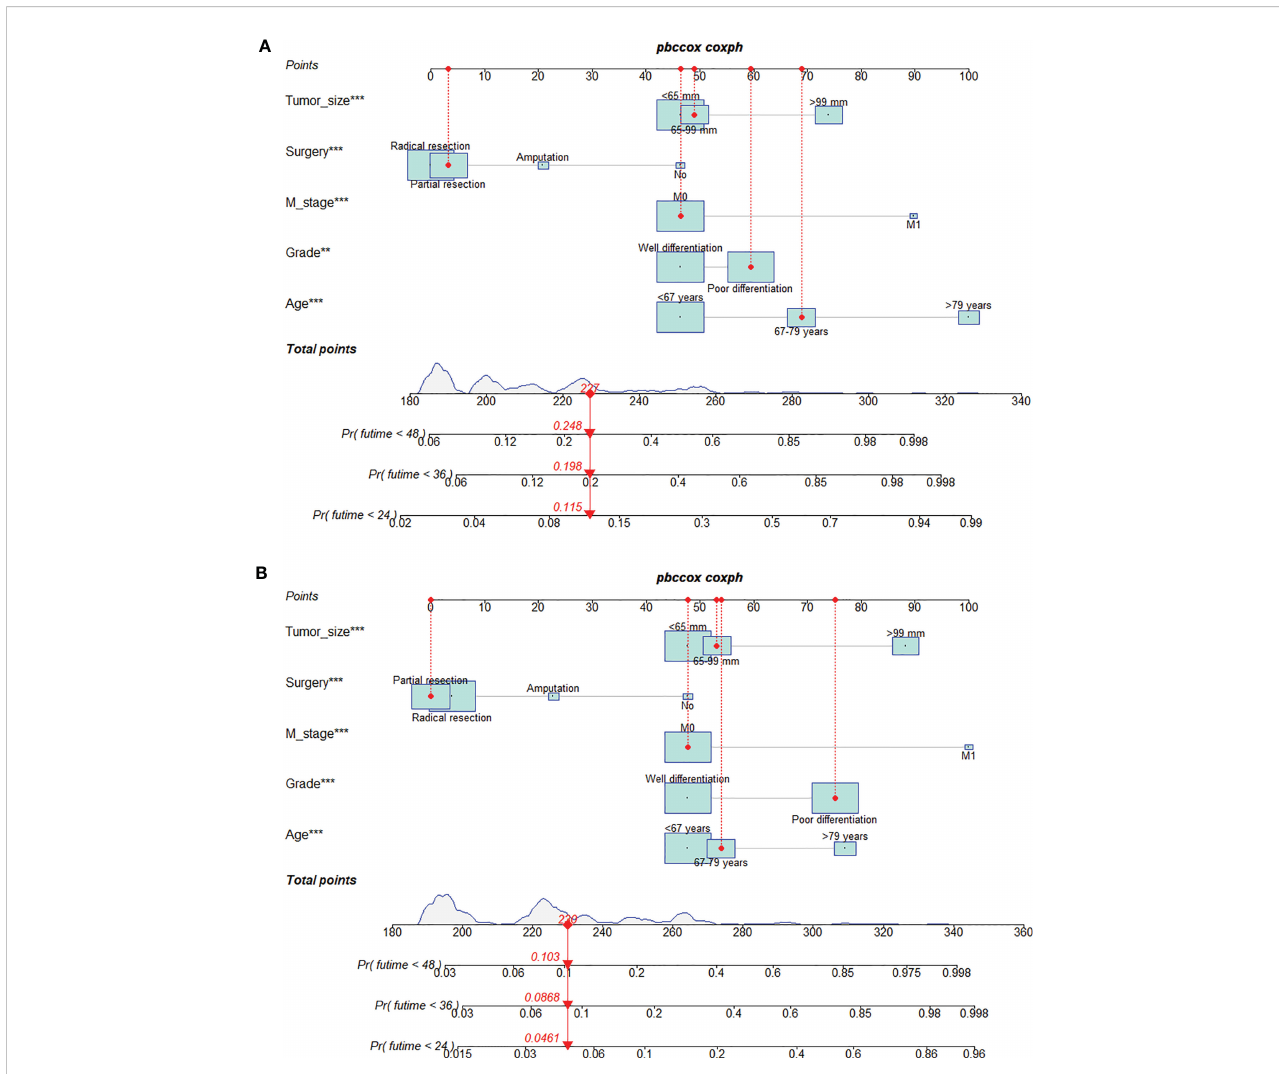
FIGURE 2 Prognostic nomogram for predicting the 24-, 36-, and 48-month overall survival (OS) (A) and cancer-speci fi c survival (CSS) (B) of patients with extremity fi brosarcoma (EF). The meaning of the symbol **, *** represented the statistical differentiation of the